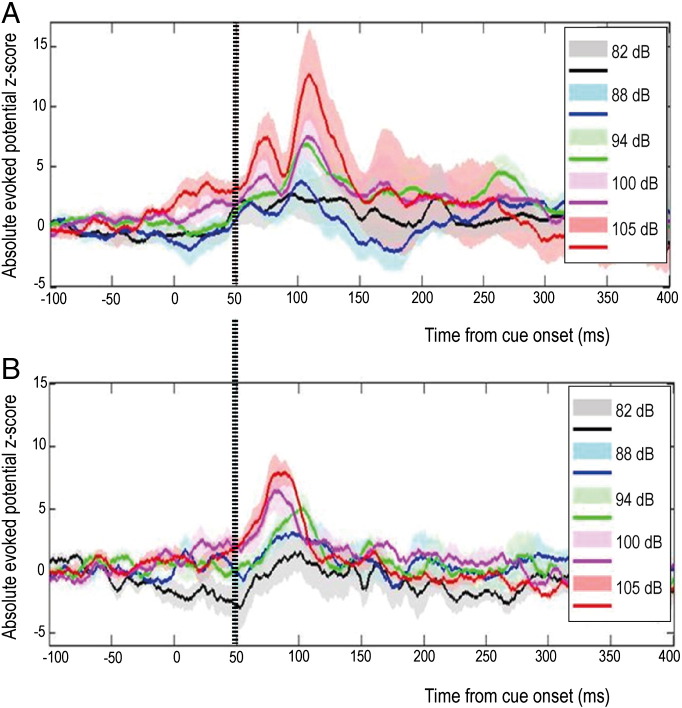
Average evoked potentials recorded simultaneously in (A) PPNr and (B) STNr. Traces represent the grand averages of recordings from left and right nuclei of a single patient whilst OFF and ON L-DOPA. Normalization technique and CI representation are as in Fig. 2. Dashed vertical line denotes the common onset latency of the first evoked potential in both structures.